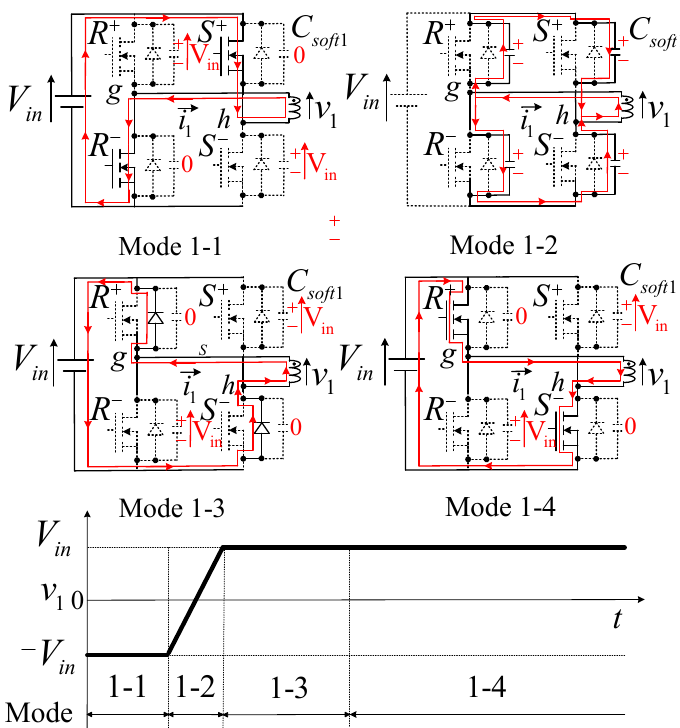
Figure 5. Soft-switching operation modes of the primary H-bridge switches circuit.